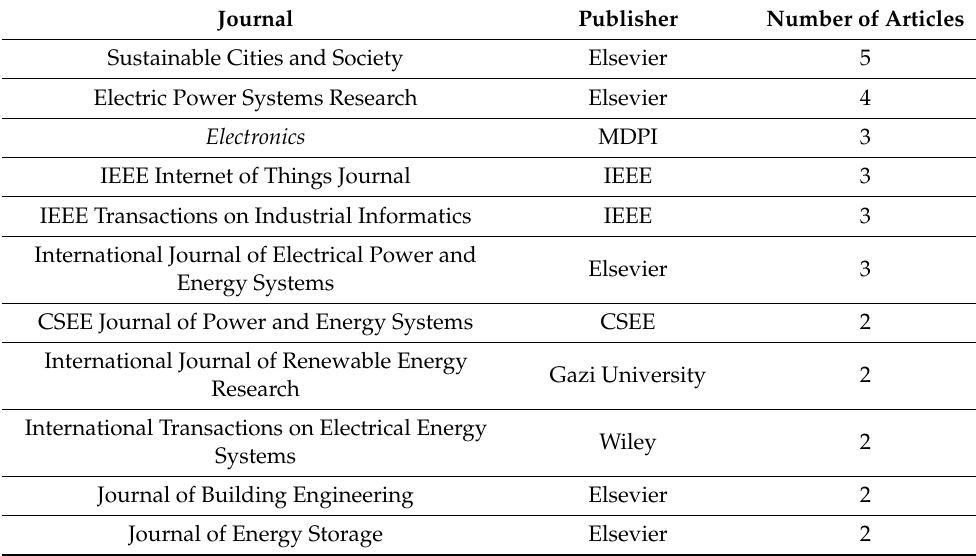
Table 3. Cont. Table 3. Journals with at least two articles in the final selection.